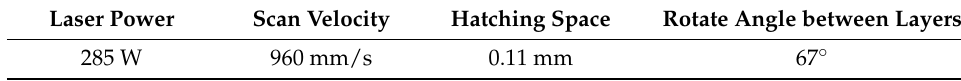
Table 2. Nominal powder size of Inconel 718 powder used in this work.